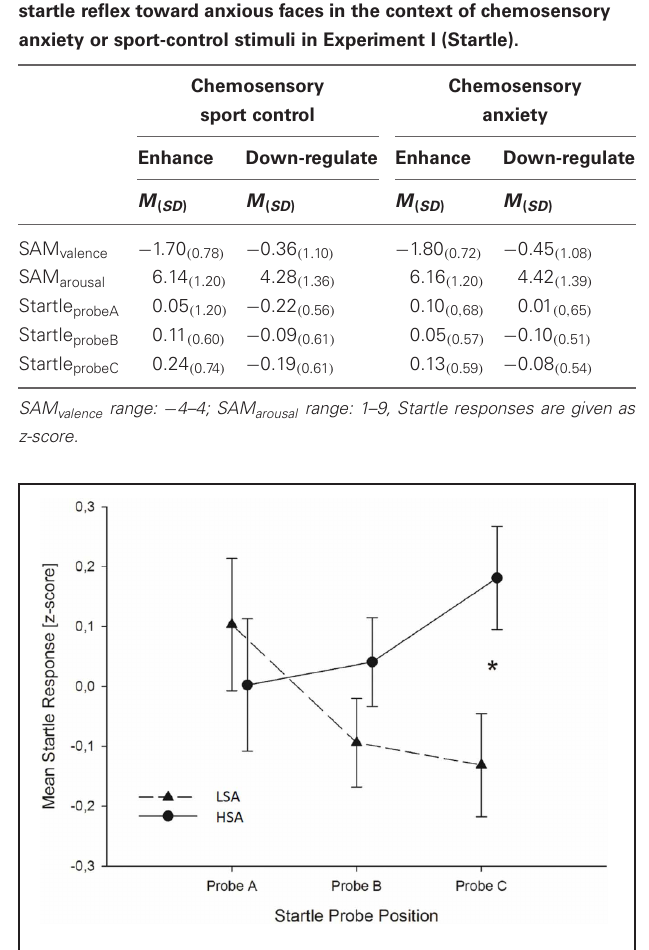
FIGURE 2 | In Experiment I, HSA participants (dashed lines) showed larger startle magnitudes than LSA participants (sold lines) toward the anxious facial expression presented in the context of the chemosensory anxiety signal during startle position C. Furthermore, for HSA participants startle responses did not differ between startle probes A, B, and C, while for LSA participants startle responses were smaller during startle probe B, and probe C, than probe A, indicating startle habituation in LSA, but not in HSA participants. ∗